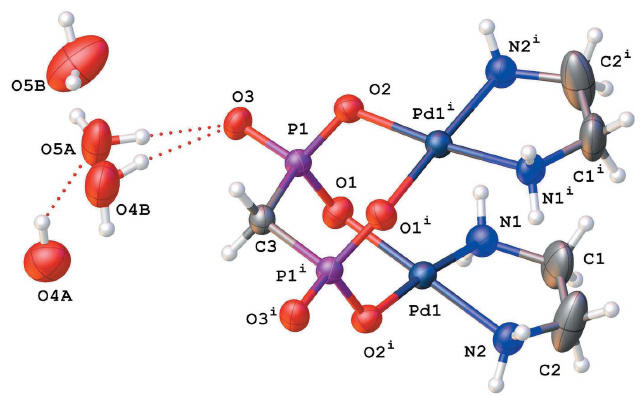
Figure 1 Molecular structure of the title complex and surrounding water molecules with displacement ellipsoids drawn at the 50% probability level. [Symmetry code: (i) (cid:4) x + 3